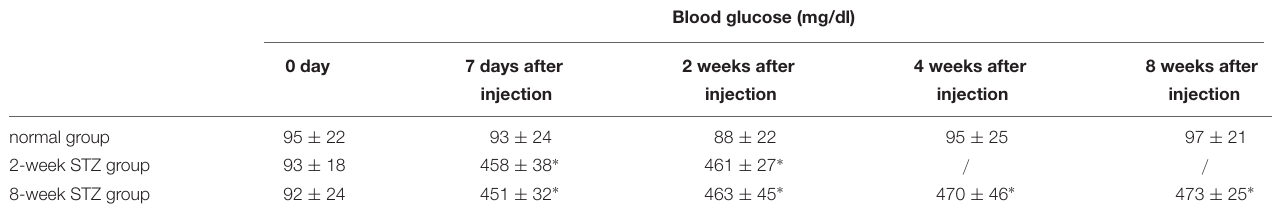
TABLE 4 | Glucose measurements in normal and diabetic rats.